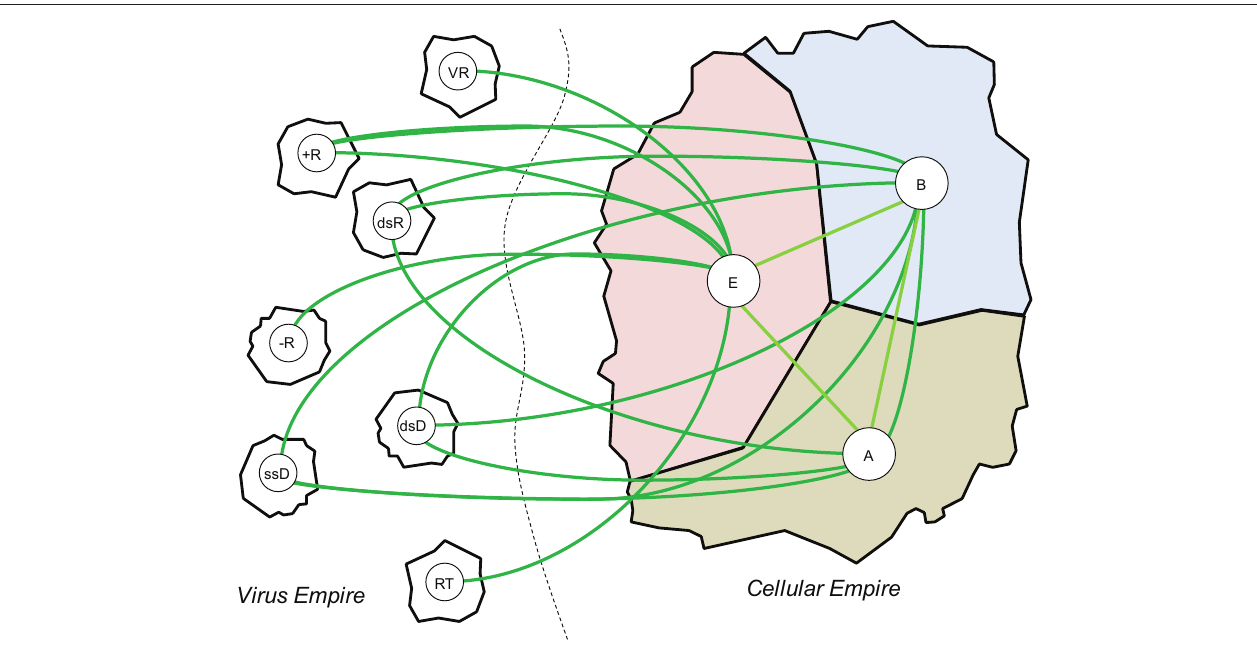
− R, negative-strand RNA viruses; dsR, double-stranded RNA viruses; dsD, double-stranded DNA viruses; ssD, single-stranded DNA viruses; RT, retro-transcribing elements/viruses; VR,